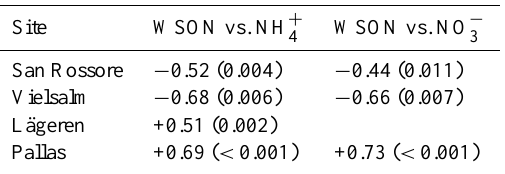
Table 4. Correlations of WSON deposition with NH + position over time within individual sites, as Spearman rank corre- lation coefficient ( ρ) with associated significance probability (Gen- Stat13, VSN International Ltd). Only significant ( p < 0.05) corre- lations are